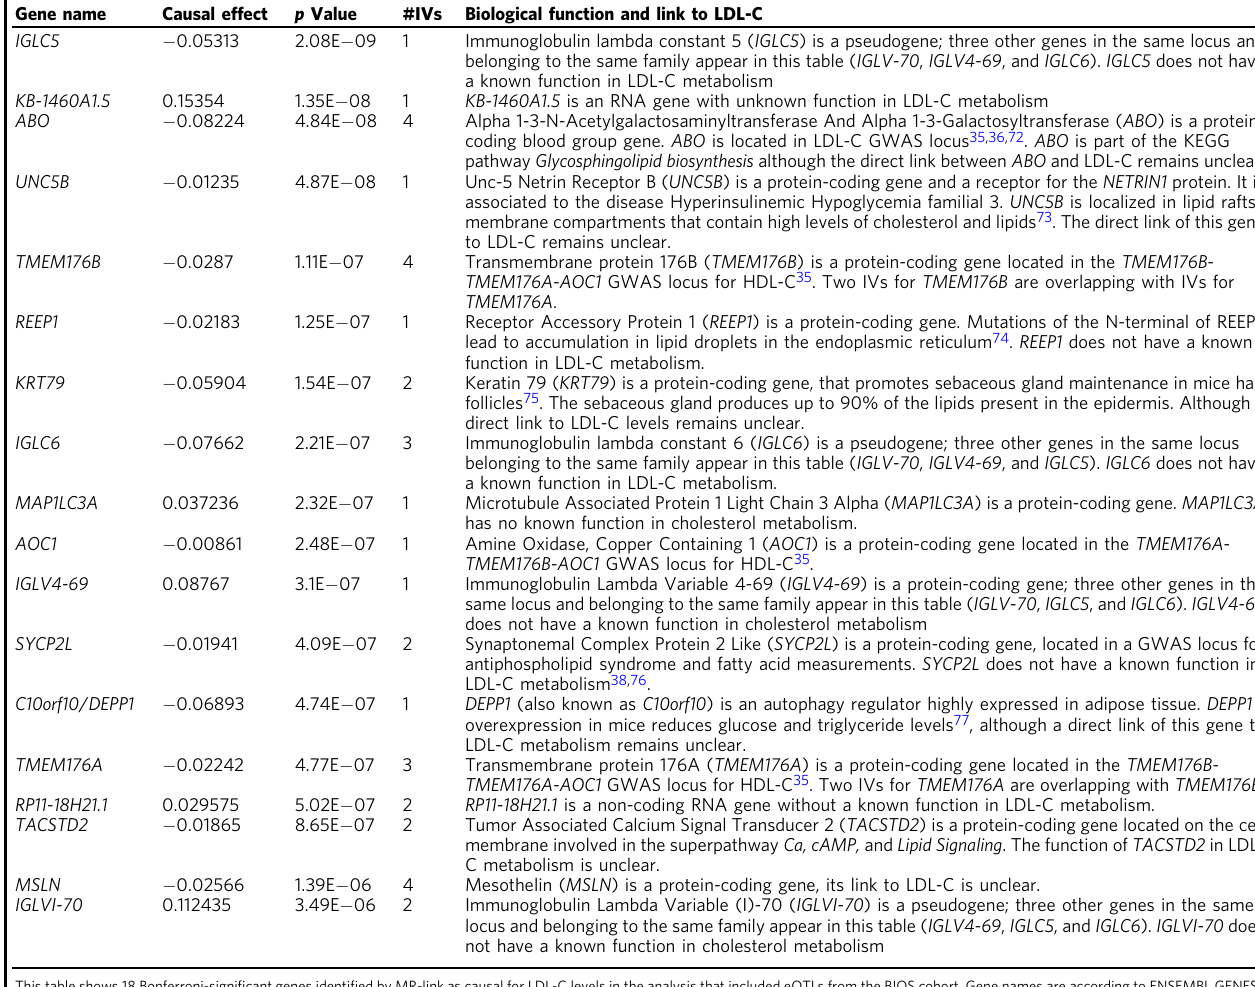
Table 2 MR-link results using BIOS blood